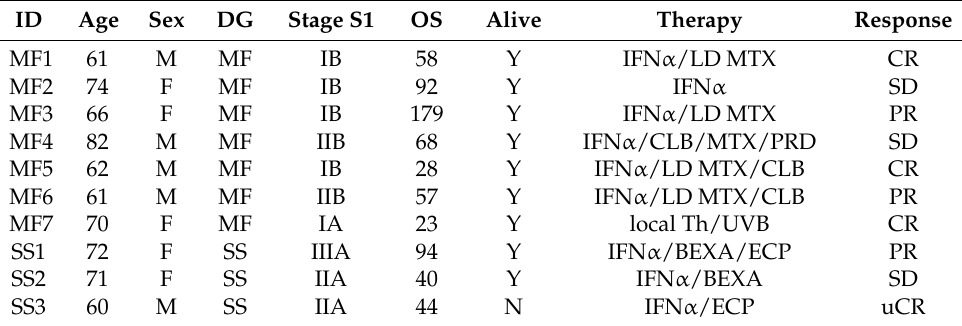
Table 1. Clinical data of the T-cell lymphomas (CTCL) patient